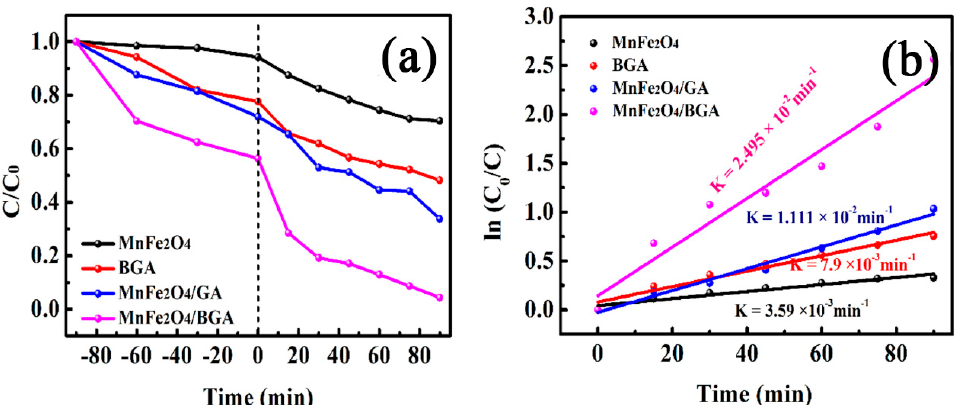
Figure 8. ( a ) The photo ‐ Fenton degradation and ( b ) corresponding pseudo first ‐ order kinetic curves of RhB on different catalysts in the presence of H 2 O 2 under visible light (catalyst dose: 2 mg, volume of 30% H 2 O 2 : 1.0 mL, [RhB]: 10 mg/L, volume of RhB solution: 50 mL). The negative minutes of the x − axis shown in Figure 8a stand for the period of pre ‐ ad ‐ sorption in the dark without addition of H 2 O 2 .